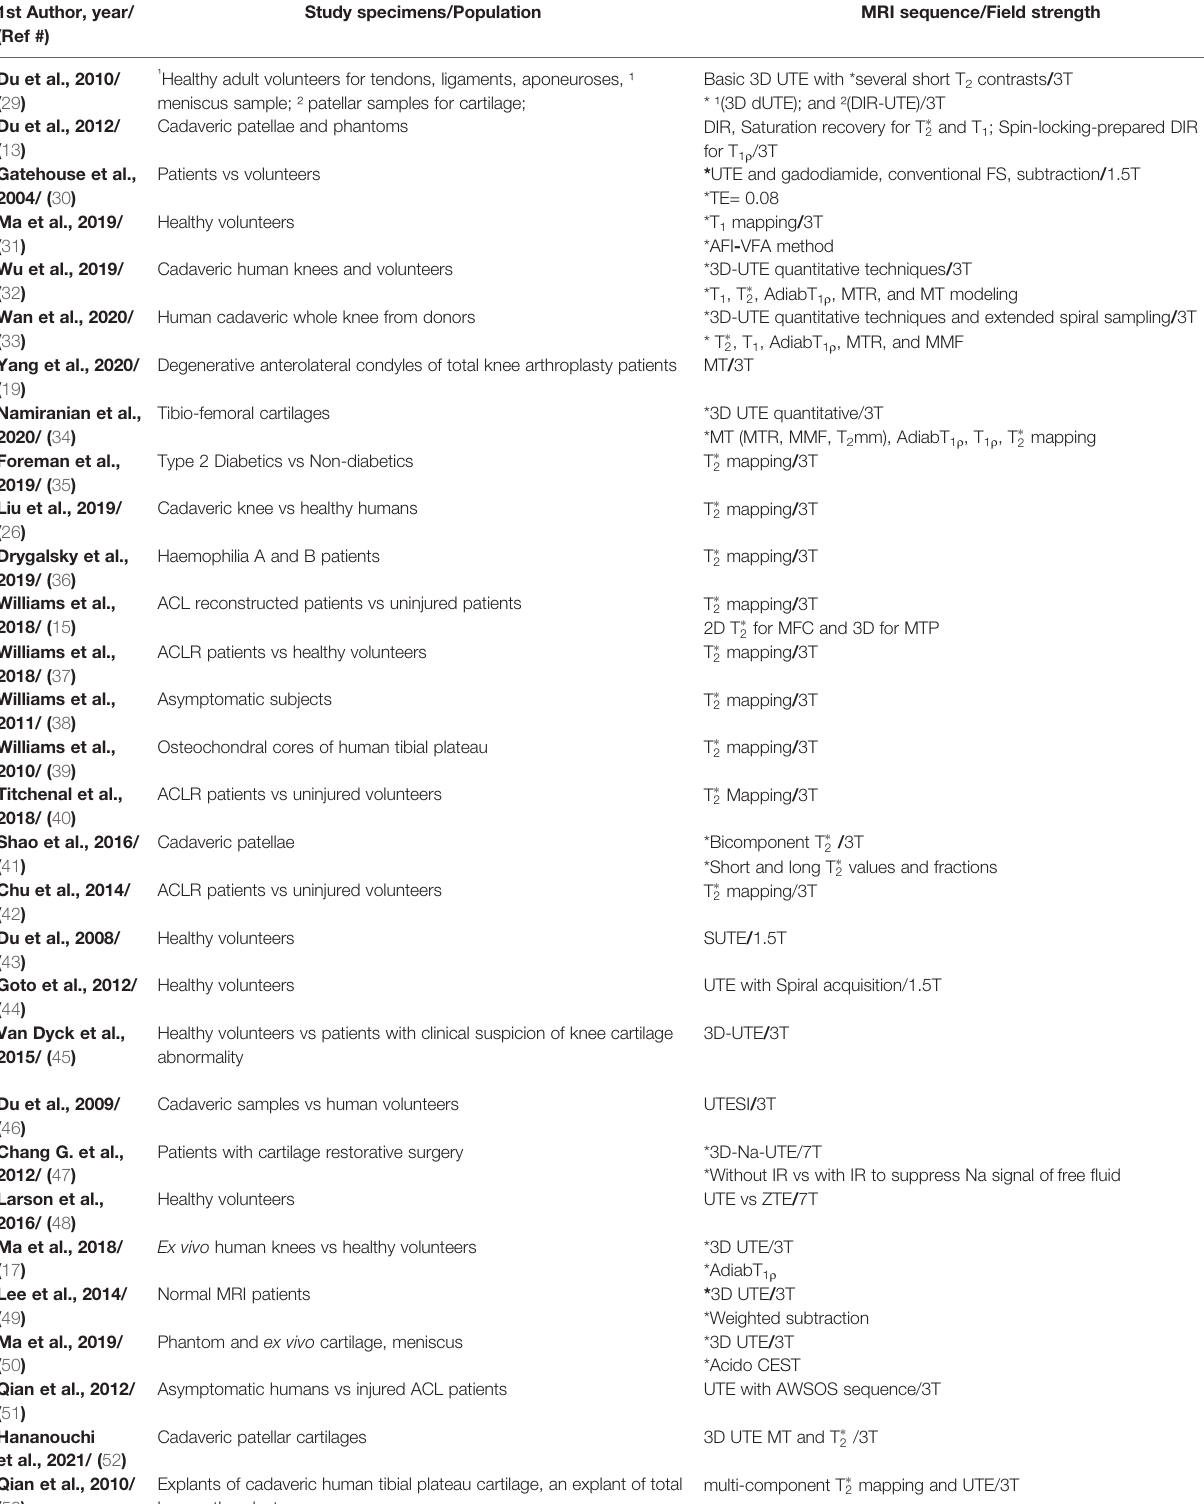
TABLE 1 | Summary of articles in UTE MRI of articular